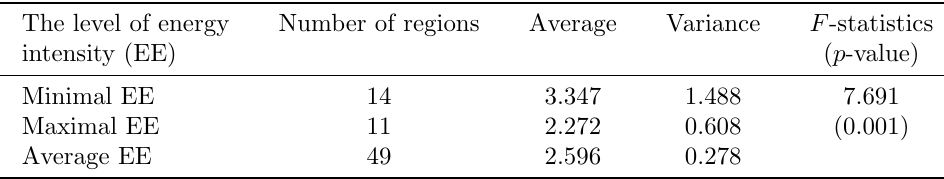
Table 4: Results of single factor ANOVA